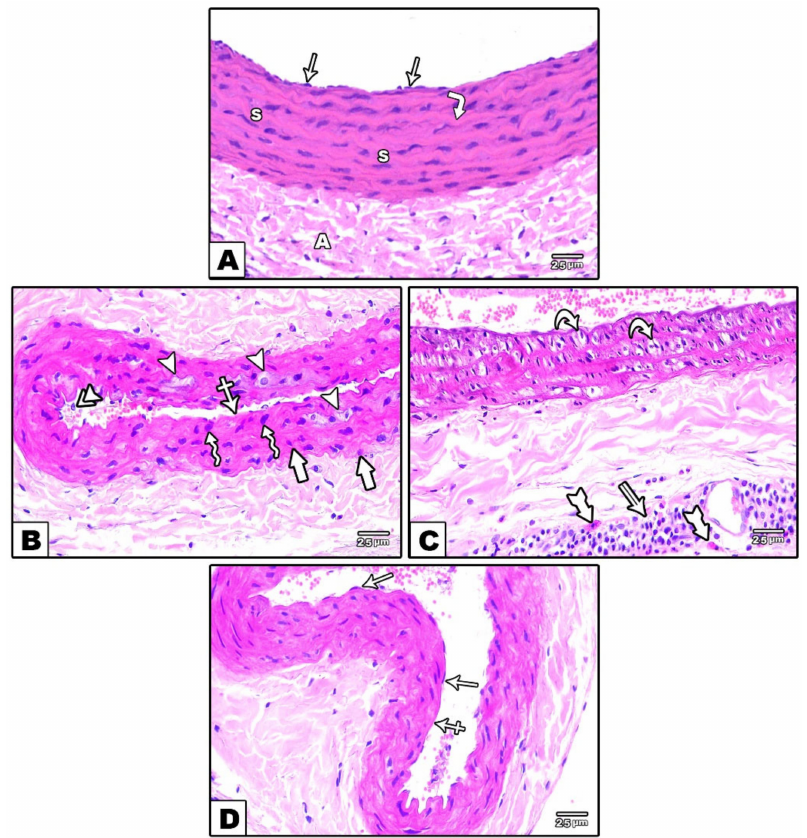
Figure 1. Photomicrographs of sections in the carotid artery stained with H&E. ( A ): In the control groups, the wall of the carotid artery consisted of thin tunica intima lined with endothelial cells (arrows), the intima mingles with the underlying media, which is formed from smooth muscle fibers (S), and wavy elastic fibers (corner arrow). The adventitia (A) is composed of loose connective tissue. ( B,C ): Reserpine-treated group. ( B ): Loss of some endothelial cells (crossed arrow) and the shedding of others (double arrowheads) in the lumen. Tunica media contains foam cells (arrowhead) and smooth muscle fibers with plump nuclei (zigzag arrows) or dark pyknotic nuclei (thick arrow). ( C ): Tunica media shows cytoplasmic vacuolation in the smooth muscle fibers (curved arrows). Tunica adventitia appears thick with inflammatory cell infiltration (double arrow) and mast cells (tailed arrows). ( D ): The fisetin-treated group demonstrated marked improvement of the wall and endothelial lining (arrows), apart from the loss of few epithelial cells (crossed